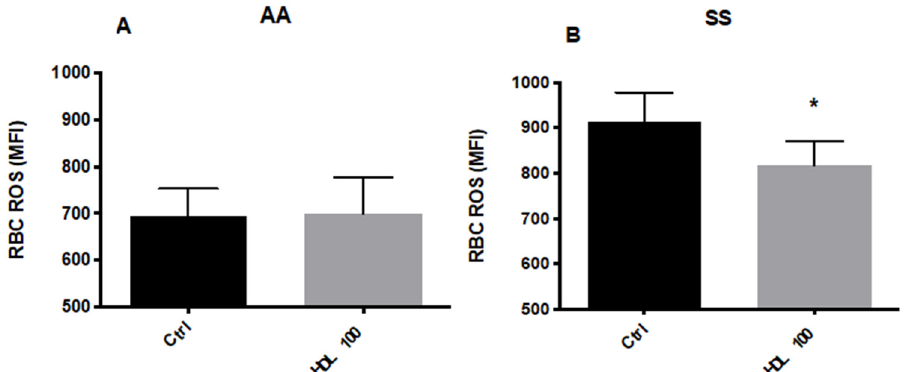
Figure 2. ROS levels in RBCs from HbAA (A) and HbSS (B) patients after incubation with human